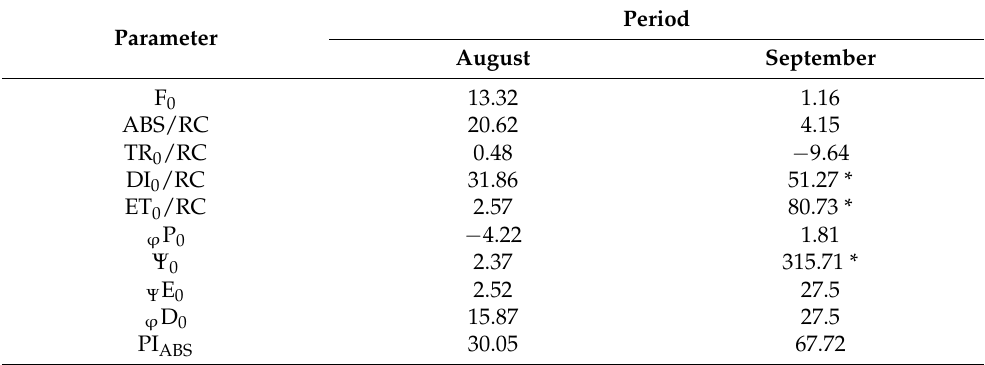
Figure 7. Midday chlorophyll fluorescence variables of Touriga ‐ Nacional grapevines in control and kaolin ‐ treated leaves throughout the experiment. Parameters measured: maximum (F v /F m ) quantum efficiency of PSII and non ‐ photochemical quenching (NPQ). Data are mean ± SD of six replicates. Different lower ‐ case letters represent significant differences ( p < 0.05) between treatments within each month. * denote significant differences ( p < 0.05) between months (August vs. September) within the treatment. Table 5. Relative difference of the JIP parameters deduced from chlorophyll a fluorescence OJIP transients in August and September in the leaves of Touriga ‐ Nacional treated with 5% kaolin. Data are mean ± SD of six replicates. * Indicates a significant ( p < 0.05) relative change in the kaolin ‐ treated group respecting to control.